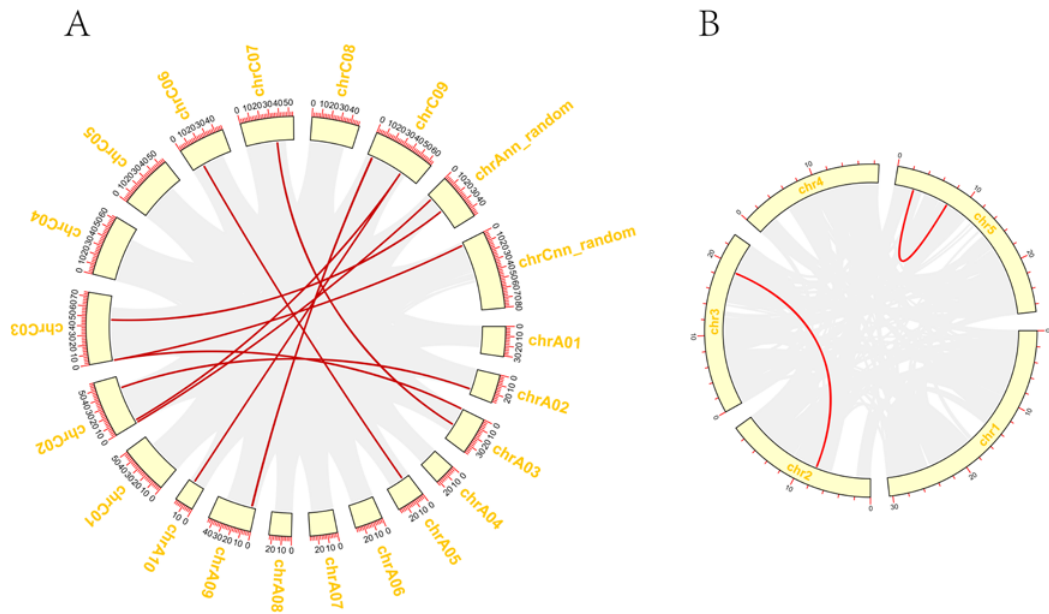
Figure 3. Duplication of BnaGYFs and AtGYFs . ( A ) Duplication of GYFs in B. napus . ( B ) Duplication of GYFs in Arabidopsis thaliana . The red line represents the gene pairs, and the yellow boxes represent the chromosomes.